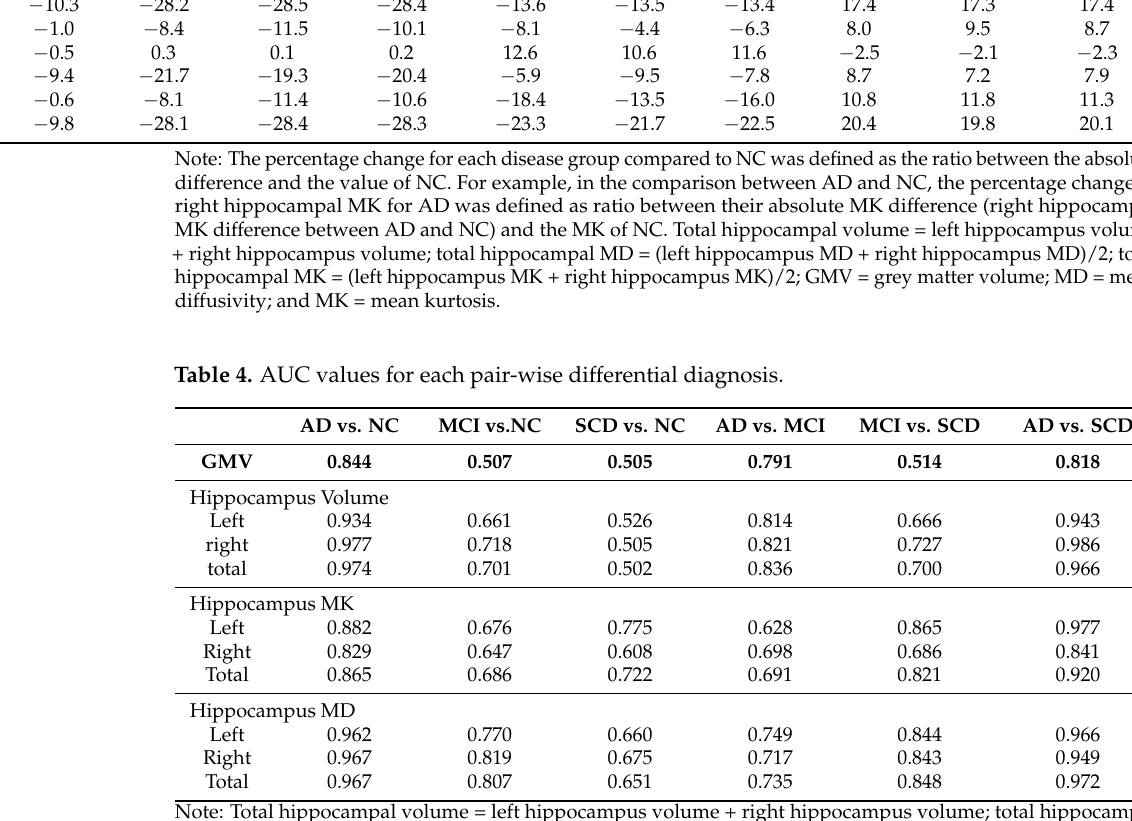
Figure 6. ROC curve for each pair-wise comparison. The statistical software SPSS (version 27) was used to do the ROC analysis. Total_Hip_MD = (left hippocampus MD + right hippocampus MD)/2;